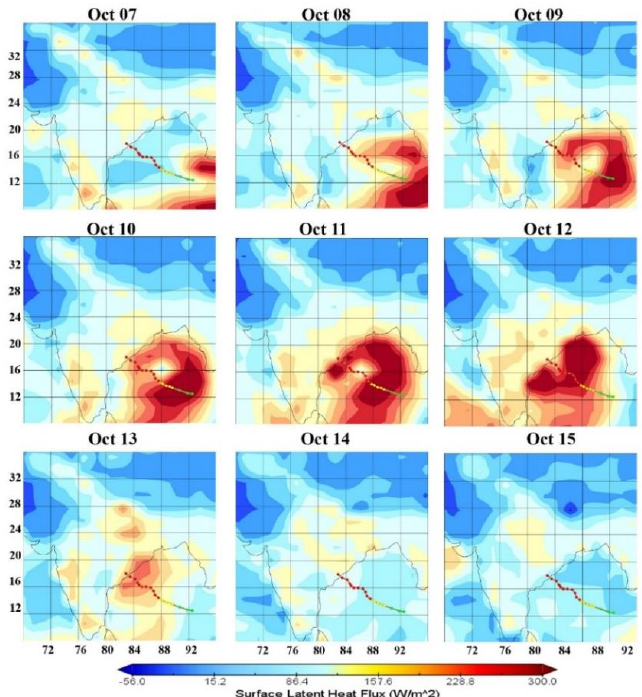
Figure 8. Spatio-temporal variation of surface latent heat lux (SLHF) during 7–15 October 2014. The colored dotted line shows the track of cyclone Hudhud.